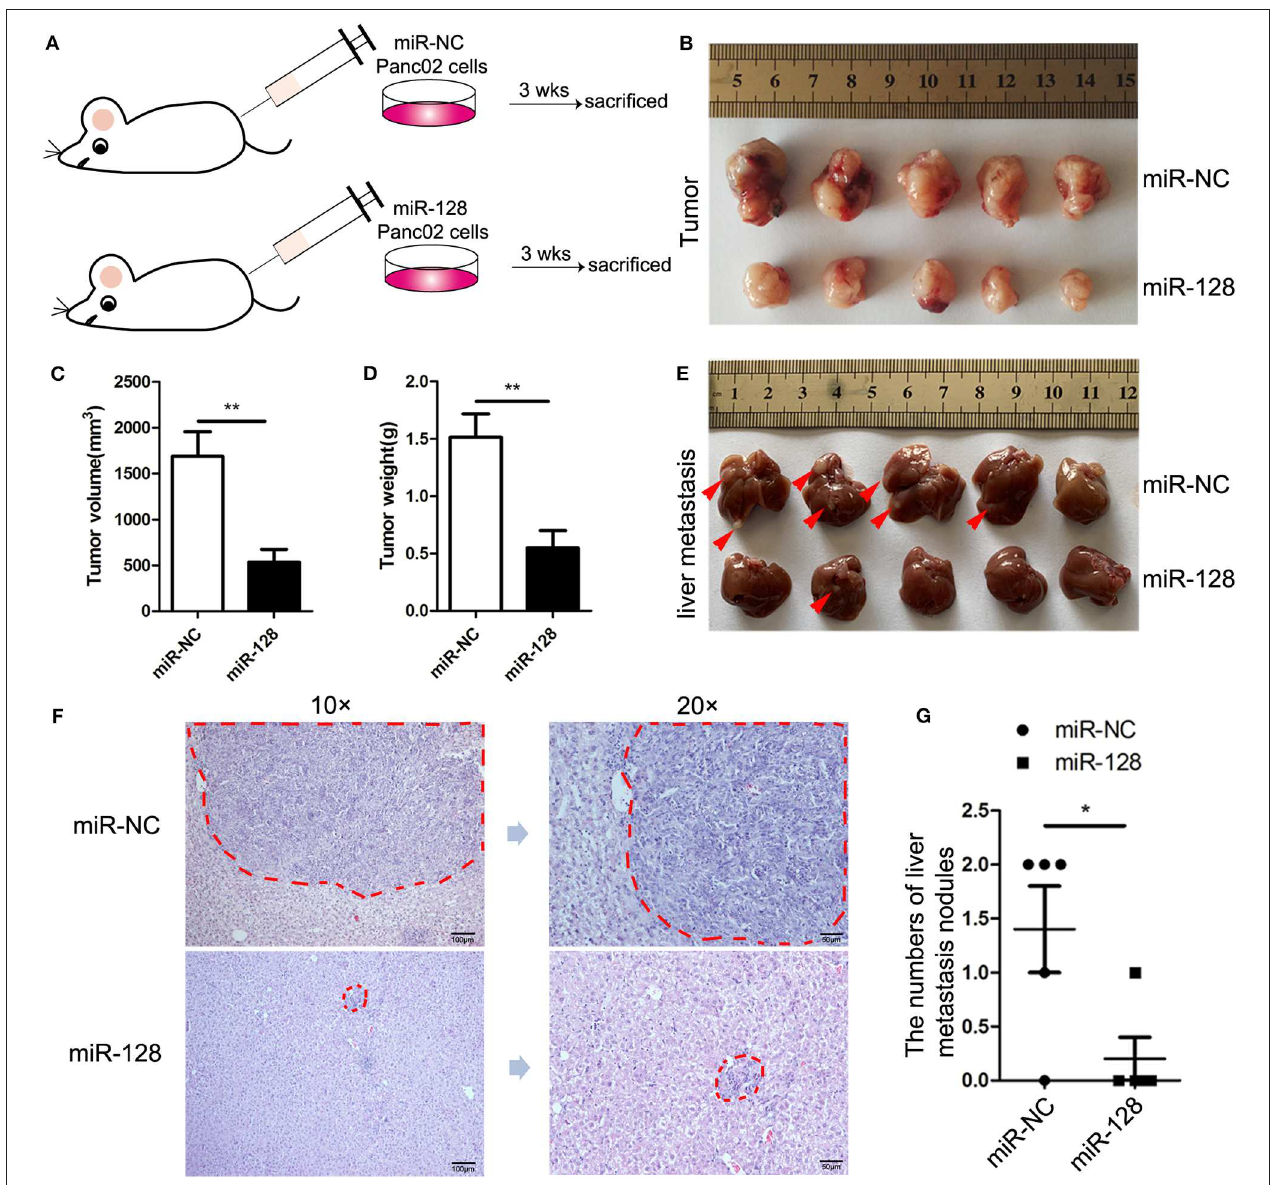
FIGURE 2 | Overexpression of miR-128 inhibited tumor growth and metastasis in PDAC. To establish the orthotopic mouse model of PDAC, miR-NC/miR-128 stable overexpression Panc02 cells were directly injected into the pancreas of C57BL/6 mice ( n = 5/group). (A) A schematic diagram of the mouse model of PDAC. (B) Typical tumor photograph. (C) Tumor volume. (D) Tumor weight. (E) Macroscopic image of liver metastasis. The red arrows point to the metastatic sites. (F) Hematoxylin and eosin (HE) staining of liver metastasis; the areas of metastasis were circled in red. (G) The statistics of liver metastasis. The results represent the mean ± SEM from three independent experiments. Comparisons between groups were determined by Student’s t -test. * p < 0.05, ** p < 0.01.